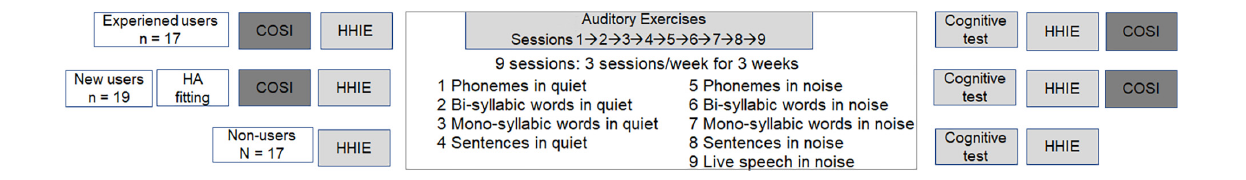
FIGURE 2 | Study design. Hearing aid candidates were fit with bilateral hearing aids and assigned to the new users group ( n = 19). Experienced users ( n = 17) and new users filled out the Client Oriented Scale of Improvement (COSI) and the Hearing Handicap Inventory for elderly (HHIE) questionnaires and the non-users ( n = 17) filled out the HHIE questionnaire. All participants trained at home for ∼ 30 min per session, at three sessions per week for 3 weeks. Overall they underwent nine sessions, four sessions in quiet and five session under background noise, as listed in the figure. After completion of the exercises program, the participants underwent a cognitive test, and filled again the